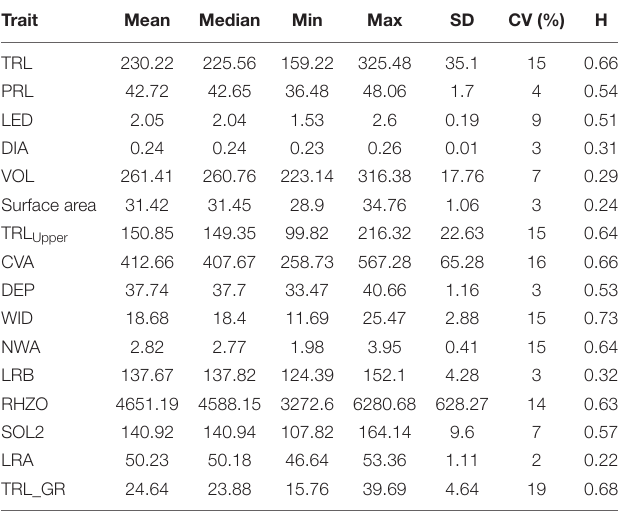
TABLE 2 | Descriptive statistics and broad sense heritability of a subset of root traits from day 15 of the Iowa (IA) mung bean genotypes estimated from eight replications.